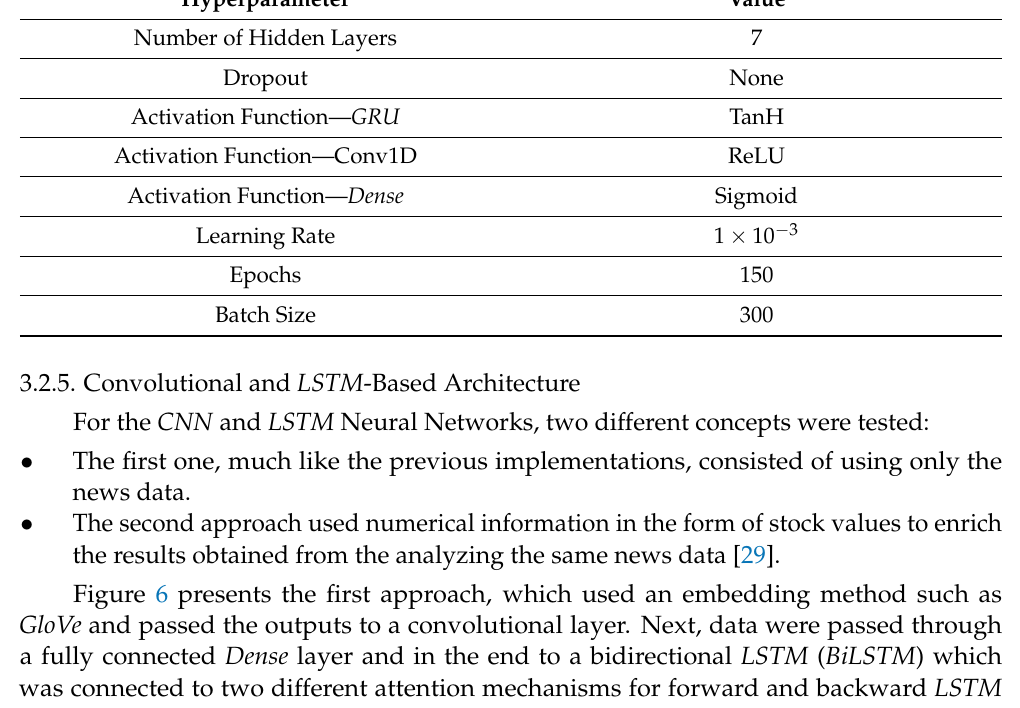
Table 5. CNN - GRU and CNN - BiGRU Hyperparameters. Table 5. CNN ‐ GRU and CNN ‐ BiGRU Hyperparameters.